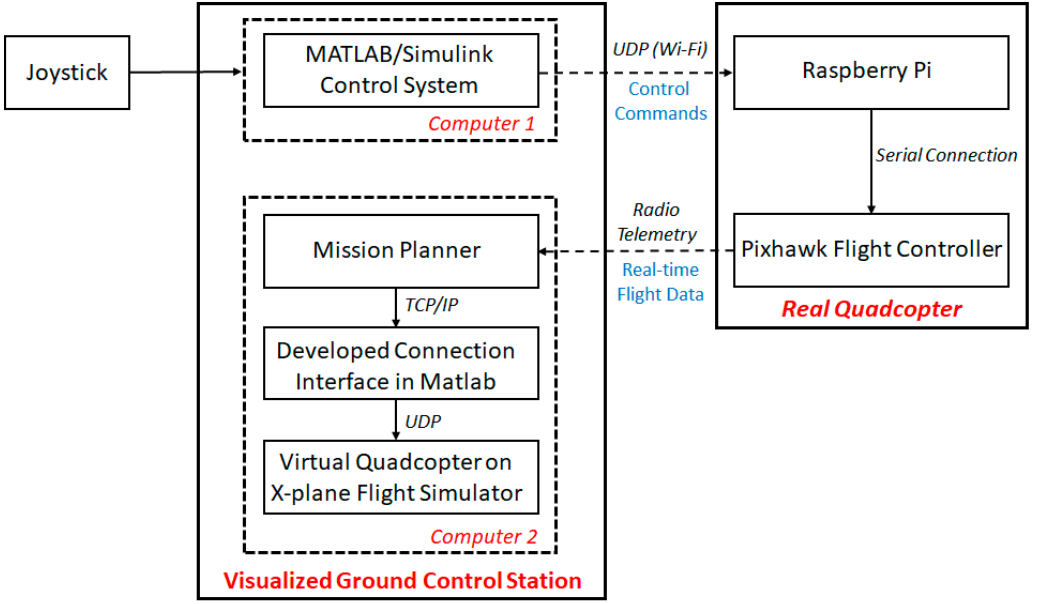
Figure 10. Overview of the visualized ground control station.